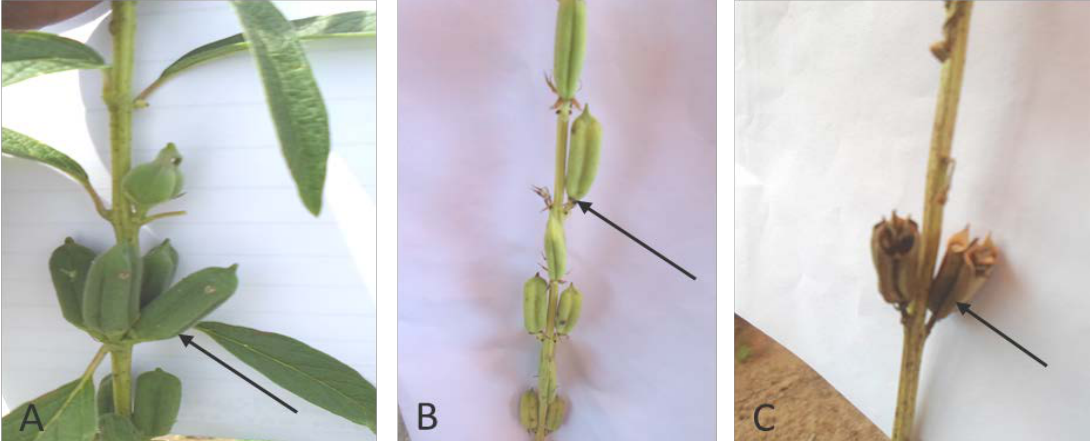
Fig. 3. Mutants from NCRIBEN-03L at 450 Gy and the control (untreated); A = a mutants with multiple capsules at leaf axil; B = control with single capsule at leaf axil; C = a mutant with tricarpellate